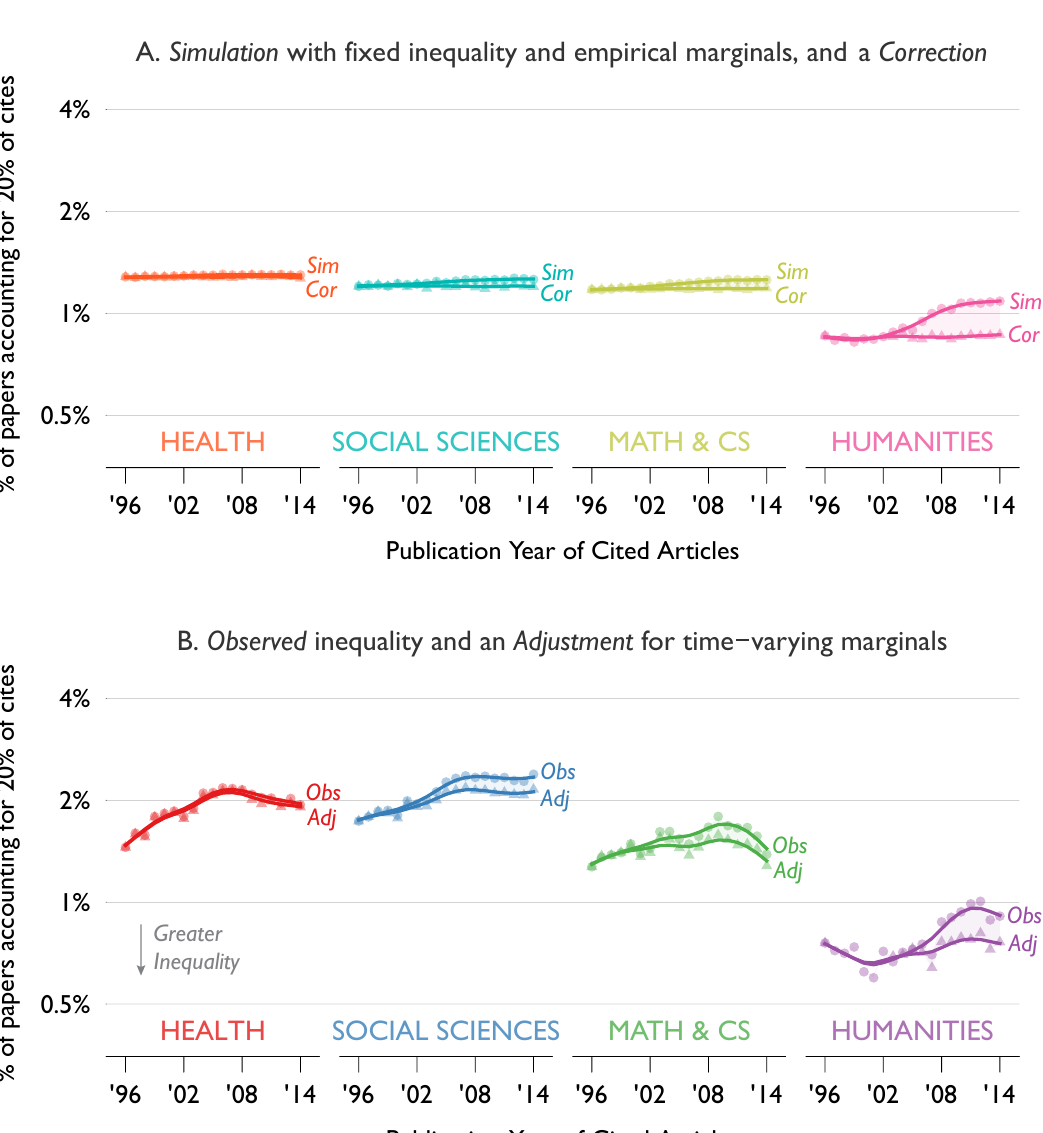
Figure 5: Percentage of articles accounting for 20 percent of all citations within two years of publication, 1996–2014: Monte Carlo simulation and empirical results. Notes : The lines in the top panel marked Sim show percentage of articles accounting for 20 percent of all citations from Monte Carlo results for hypothetical articles and citations designed to have a fixed pattern of inequality across years and fields, but total articles and citations matching the empirical marginals of those fields by year. The lines marked Cor remove the marginals bias using a resampling correction. The lines marked Obs in the bottom panel show the percentage of articles accounting for 20 percent of citations over fields and time using the empirical data from Web of Science; these results are subject to marginals bias from differences in total articles and citations by field and year. Lines marked Adj adjust for marginals bias in the empirical data by resampling to the marginals in 1996 by field. Corrections and adjustments are omitted for the humanities in 1997–2002. All curves are smoothing splines with a span of 0.5. One exceptionally highly cited article in mathematics and computer science is